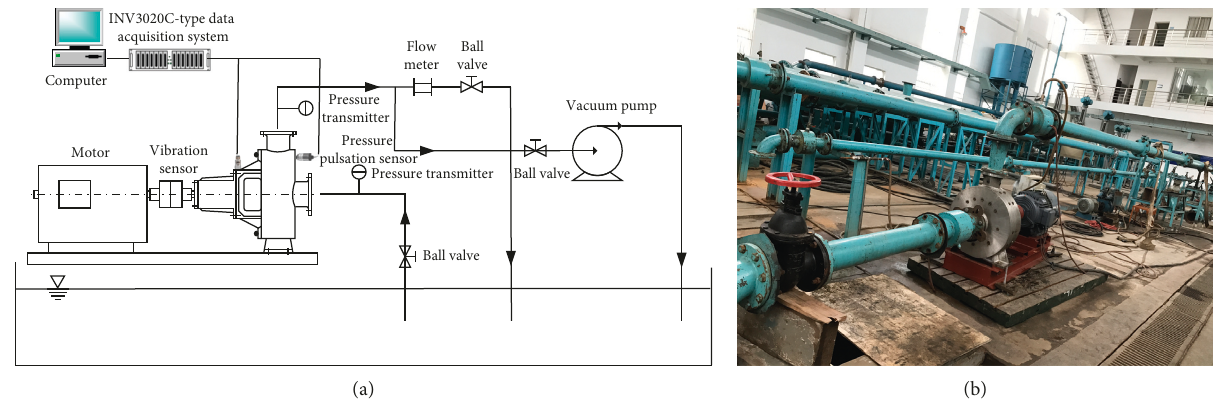
Figure 3: (a) Sketch of the experiment bench. (b) Experiment bench of the centrifugal pump with vaned